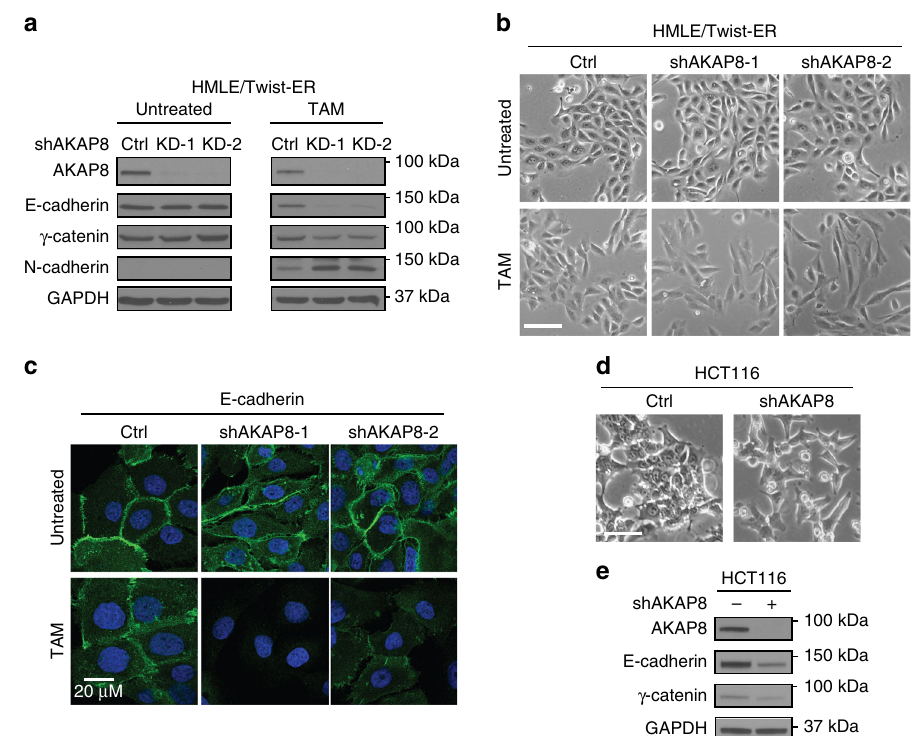
Fig. 2 Depletion of AKAP8 promotes an EMT phenotype. a Western blot analysis of EMT markers using lysates from HMLE/Twist-ER cells expressing control shRNA (Ctrl) or AKAP8 shRNAs (KD-1, KD-2). Lysates were collected before (untreated) and after 12 days of tamoxifen (TAM) induction. b Phase- contrast images (× 10) displaying cell morphology differences between control (Ctrl) and AKAP8-silenced HMLE/Twist-ER cells before (untreated) and after 12 days of TAM induction. White line represents scale bar at 100 μ m. c Immuno fl uorescence images (× 40) showing the loss of E-cadherin at cell junction 12 days after TAM treatment in the AKAP8 knockdown cells. Green: E-cadherin, Blue: DAPI. d Phase-contrast images of HCT116 cells showing cell morphology changes upon AKAP8 knockdown. White line represents scale bar at 100 μ m. e Western blot analysis of the epithelial markers in HCT116 cells expressing control or AKAP8 shRNA. Source data are provided as a Source Data fi